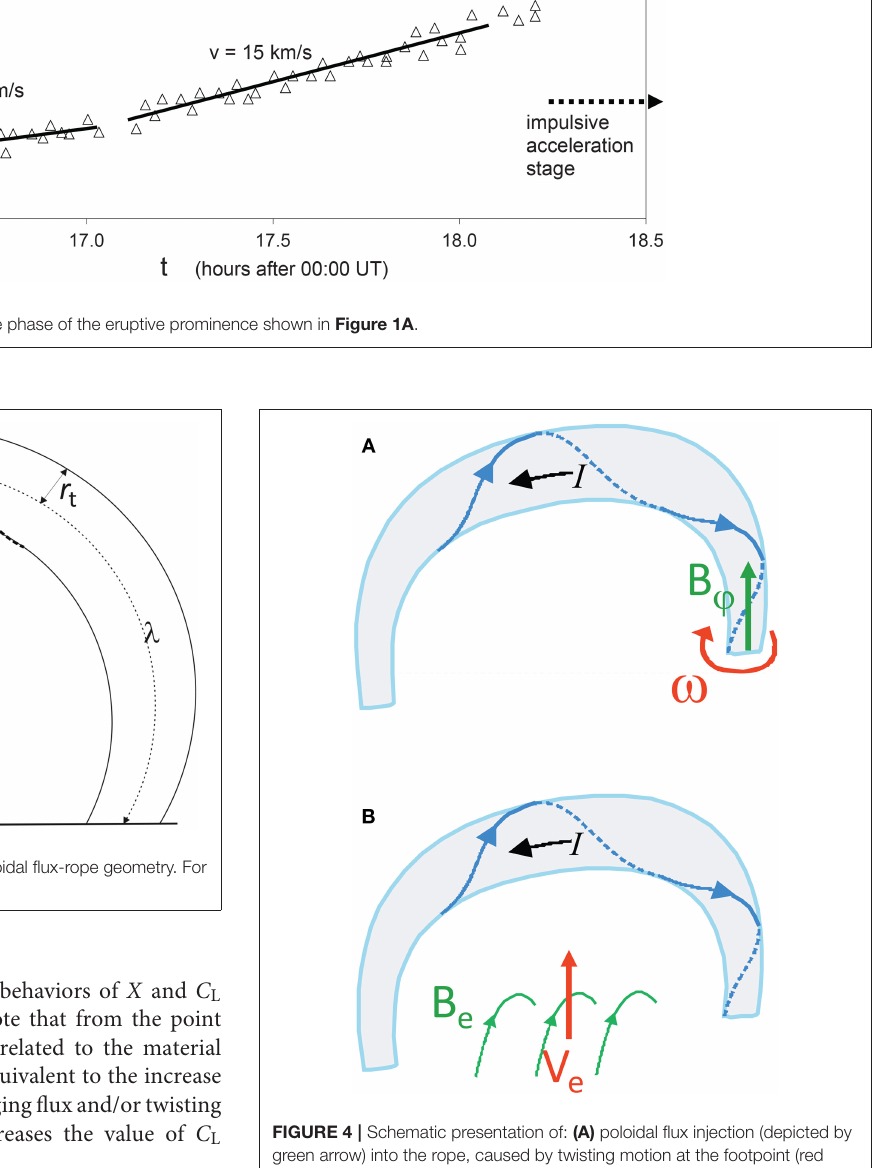
flux-rope footpoint half-separation is taken as d = 50 Mm and the axial field as B k = 100 G. The presented cases correspond to the longitudinal magnetic flux of 9 k ≈ 0.8 × 10 20 Mx (red curve) and 9 k ≈ 3 × 10 20 Mx (gray and blue curve), as listed in 7th column of Table 1